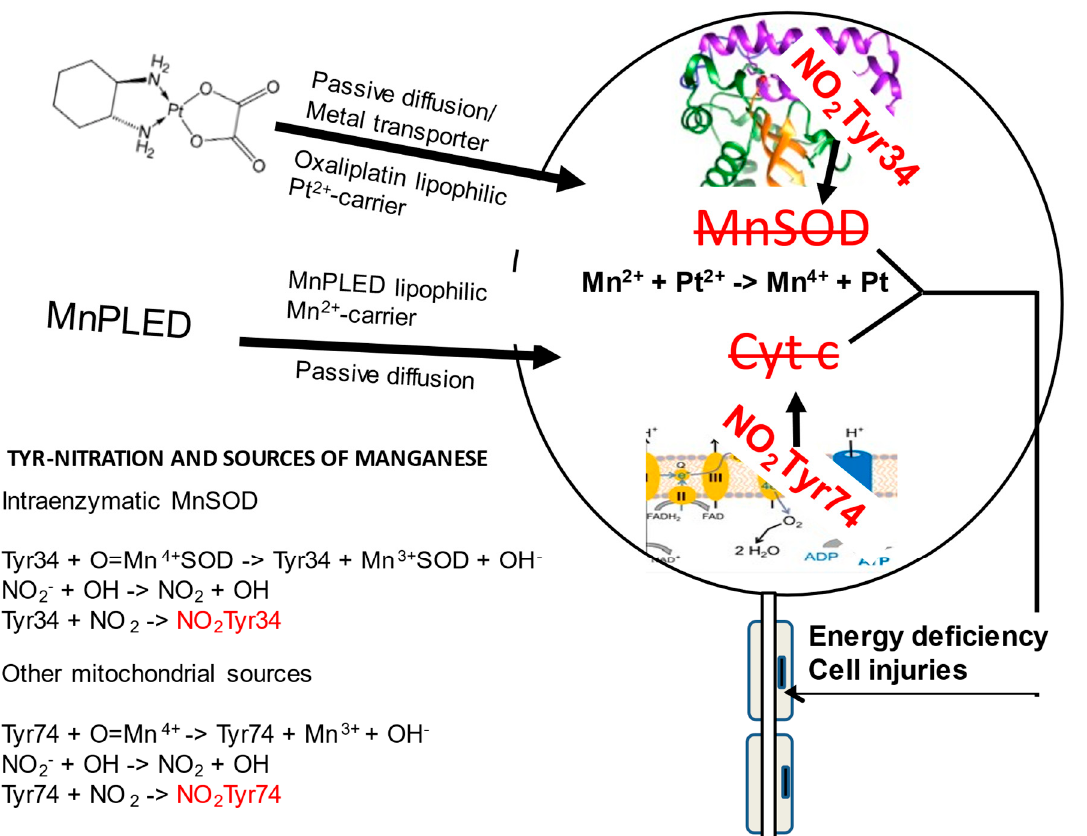
Figure 2. Schematic illustration of a DRG neuron showing two tyrosine nitration reactions taking place during high oxidative stress, relevant to co-administration of manganese-containing PledOx and platinum-containing oxaliplatin. High oxidative stress due the presence of Pt 2+ causes oxidation of Mn 2+ /Mn 3+ to Mn 4+ and simultaneously a reaction between superoxide (O 2 − ) and nitric oxide (NO) forming highly toxic peroxynitrite (ONOO − ). In presence of Mn 4+ , ONOO − nitrates two mitochondrial tyrosine residues, Tyr34 in the hMnSOD and Tyr74 in the cytochrome c, resulting in irreversible enzyme inactivation and disturbed electron transport, as illustrated to the right. DRG influx of lipophilic oxaliplatin and the MnDPDP metabolite MnPLED is illustrated to the left, and below that illustration, manganese sources together with tyrosine nitration chemistry are shown.